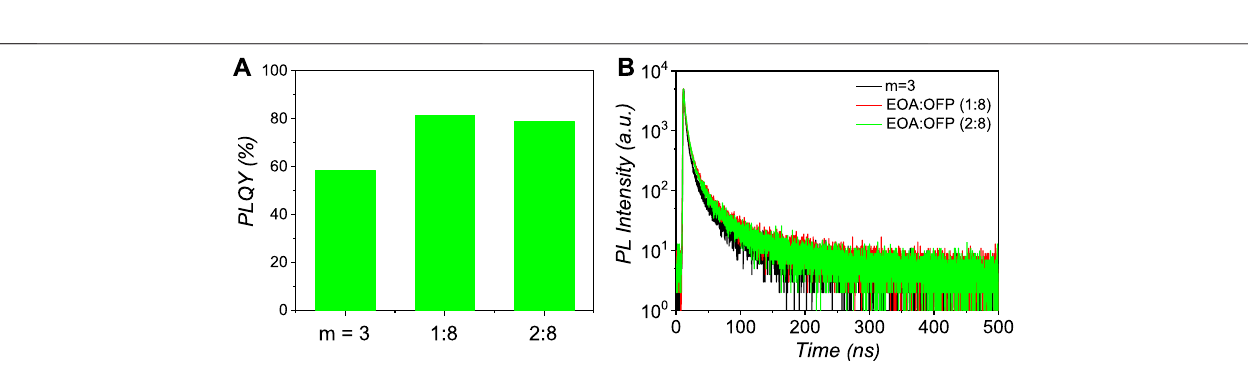
FIGURE 2 | (A) PLQY and (B) time-resolved PL decay curves of the corresponding Q-2D perovskite fi lms with different interlayers.